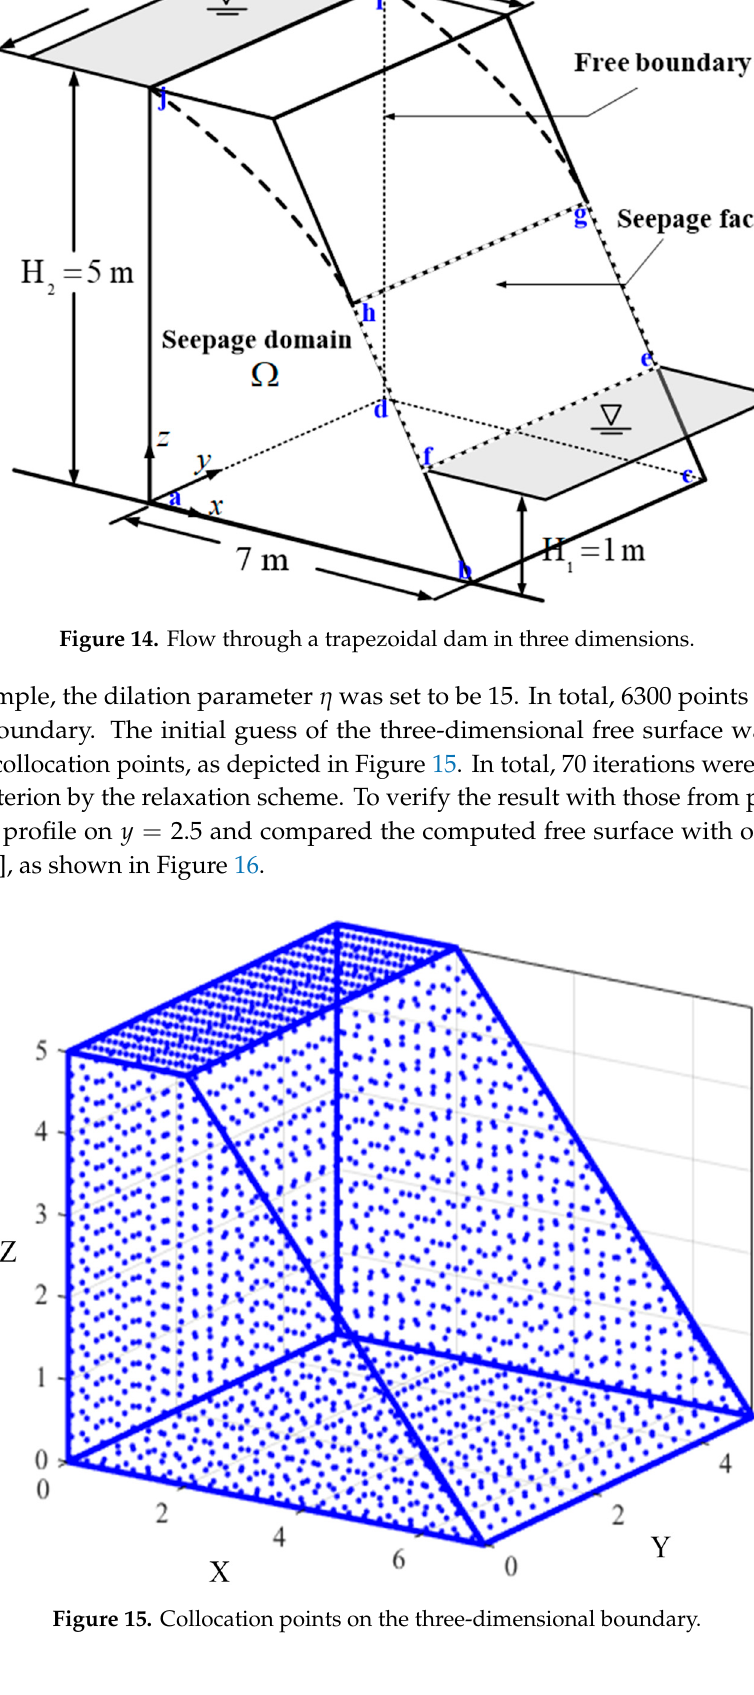
Figure 15. Collocation points on the three-dimensional boundary.